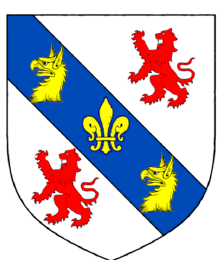
Figure 3. The Arms of Lynes, as blazoned in the text.